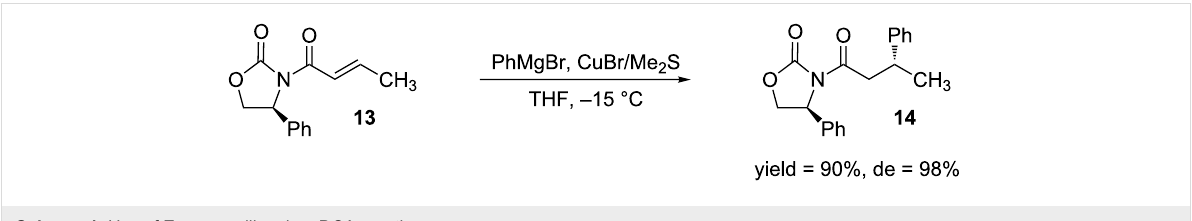
Scheme 4: Use of Evans auxiliary in a DCA reaction.